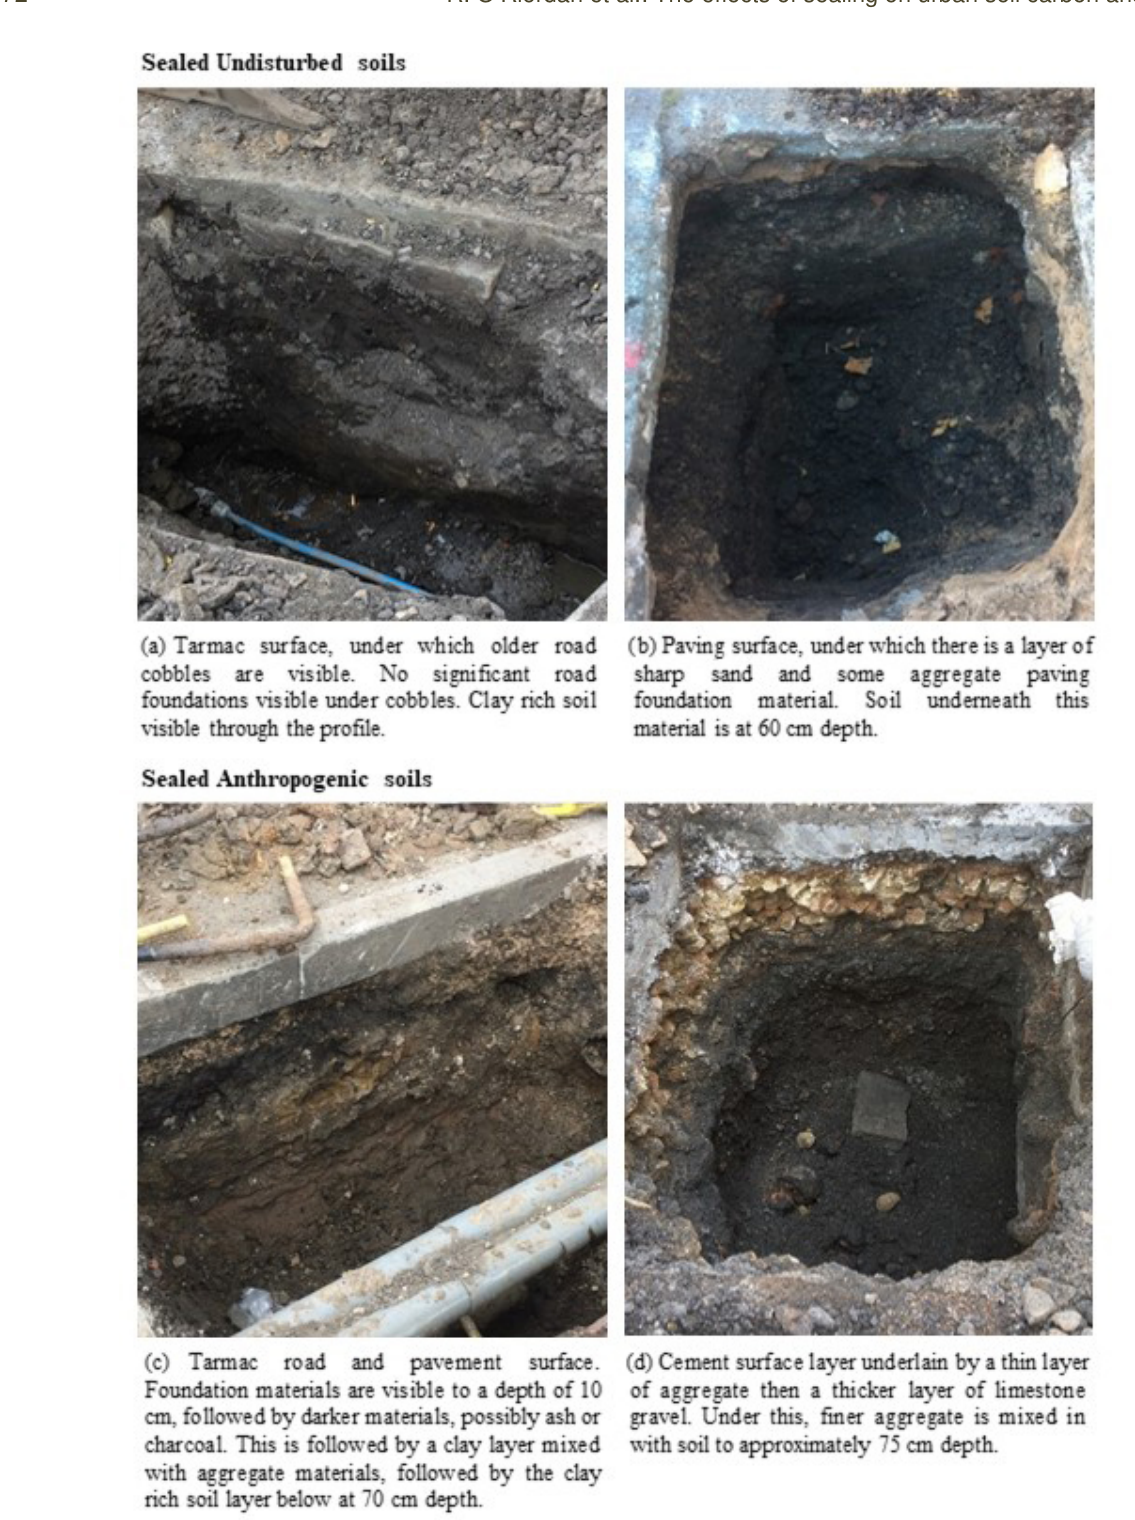
Figure A1. Examples of sealed soil profiles with descriptions, showing (a–b) sealed undisturbed (SU) soils and (c–d) sealed anthropogenic (SA)